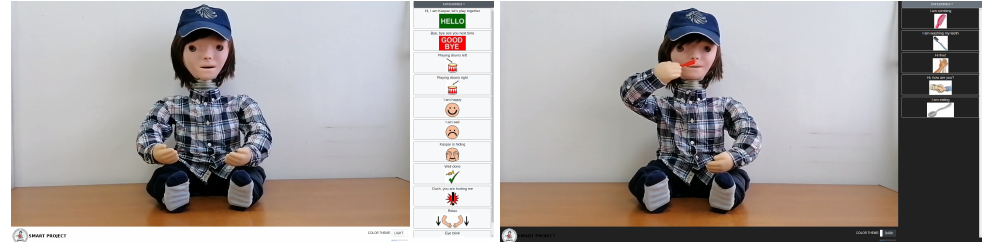
Figure 4. Main page web and mobile application (light and dark